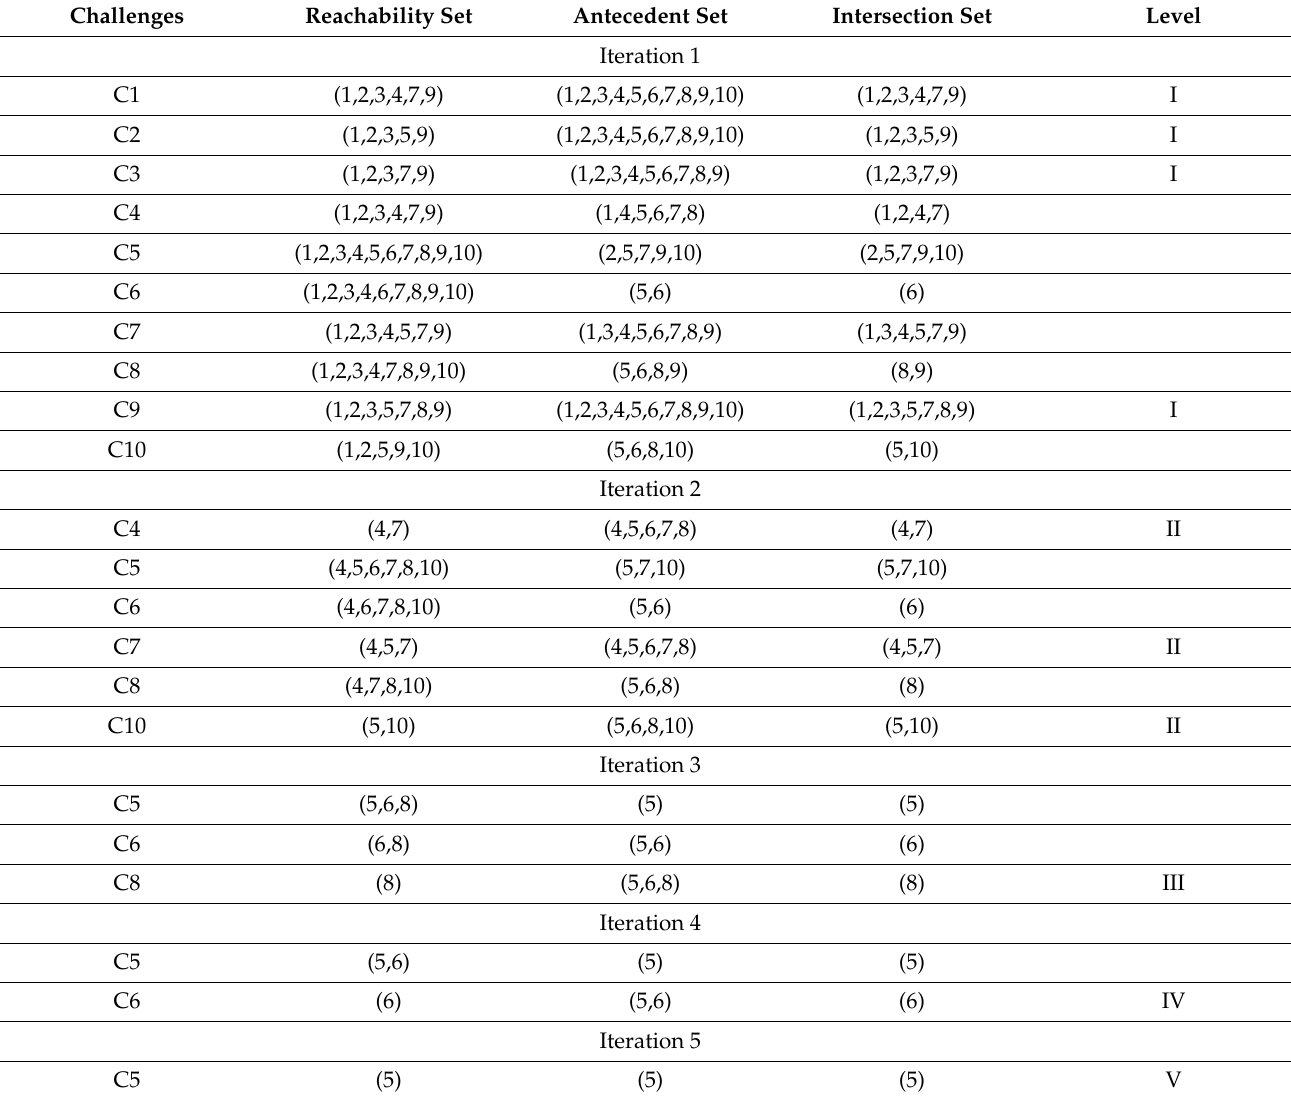
Table 6. Level partitioning for I4.0